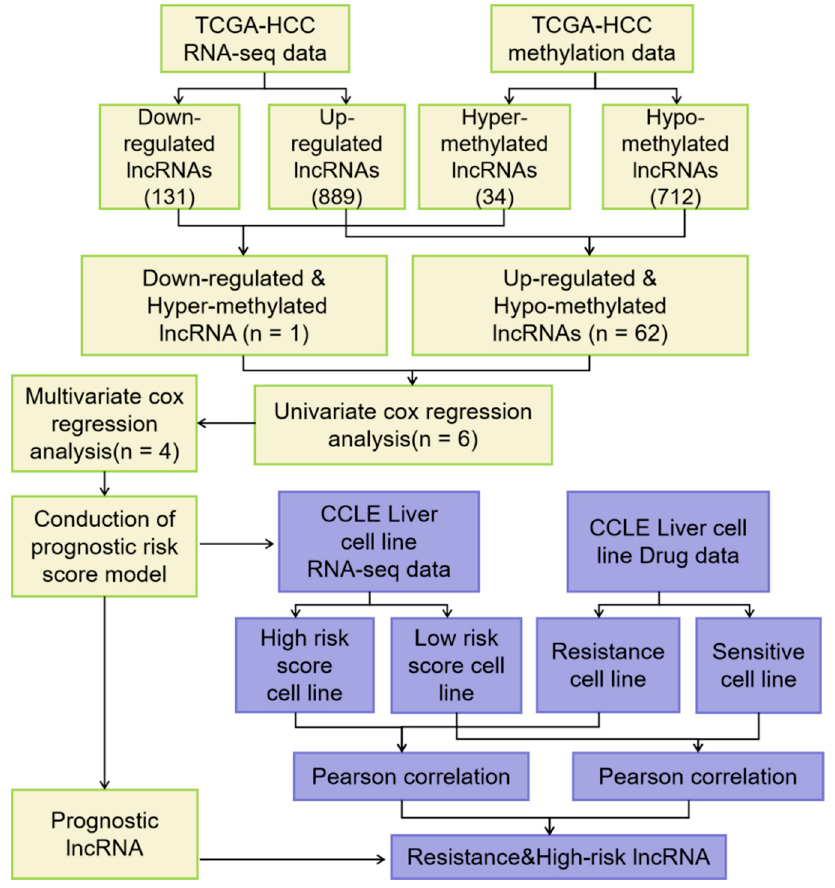
Figure 1. Flowchart of the study.